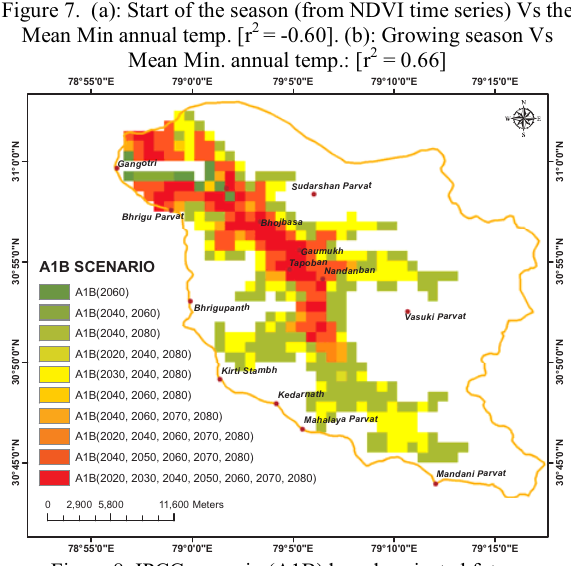
Figure 8. IPCC scenario (A1B) based projected future fundamental environmental niche of Betula utilis